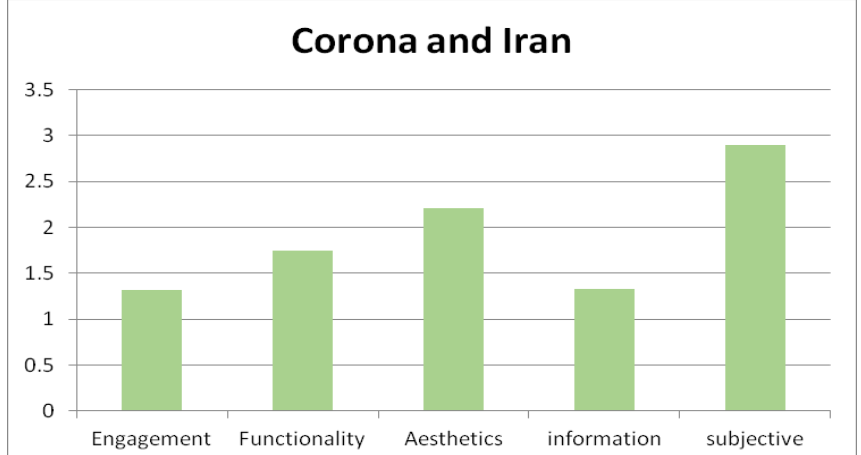
Fig15. The evaluation of indicators in Corona and Iran according to MARS